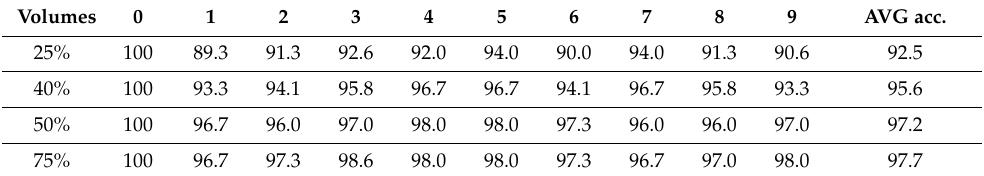
Table 2. The recognition accuracy vs. different volumes of training dataset (%).